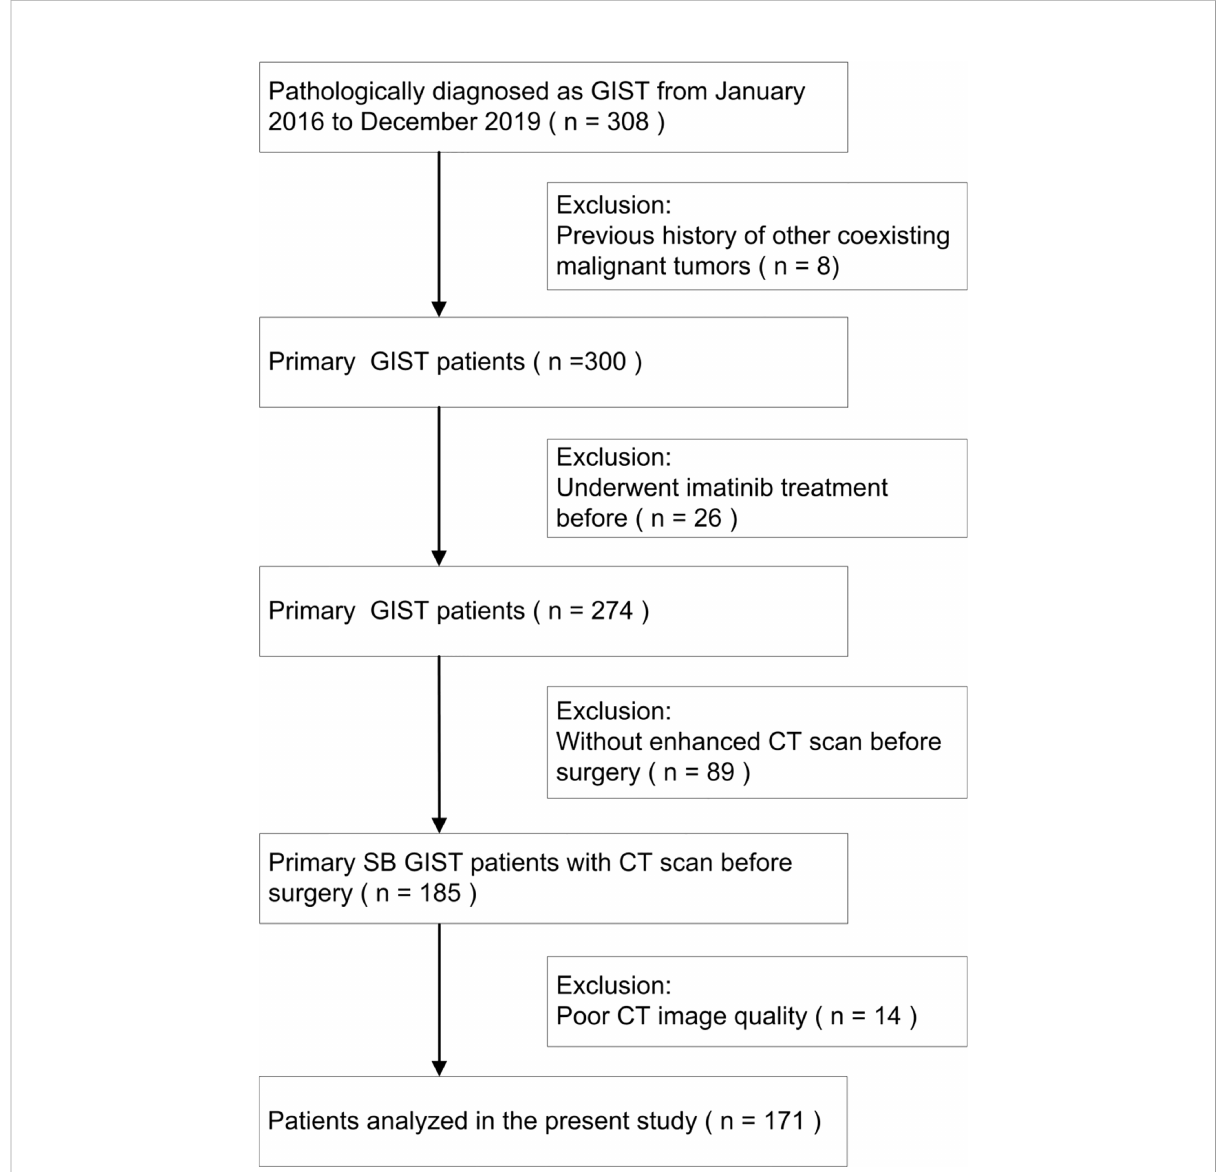
FIGURE 1 A fl owchart shows selection of study population and exclusion